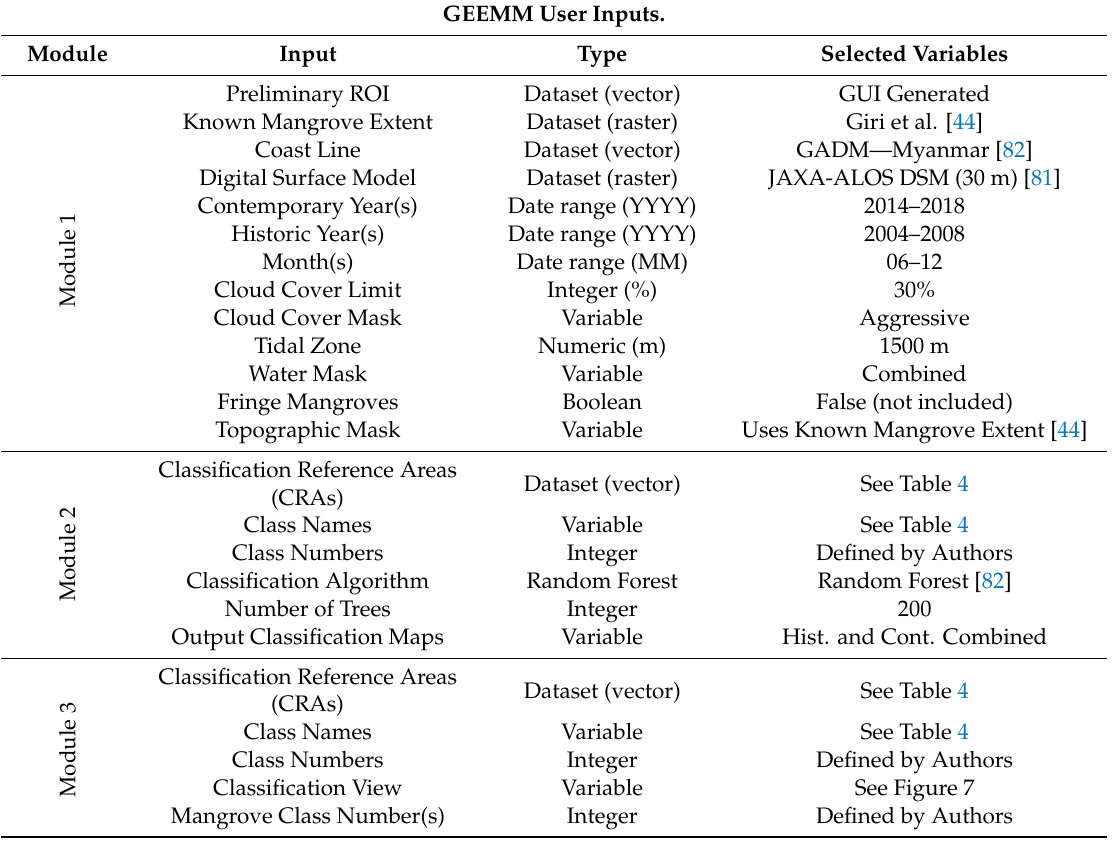
Table 2. Summary of GEEMMM user inputs and selected variables used in the Myanmar